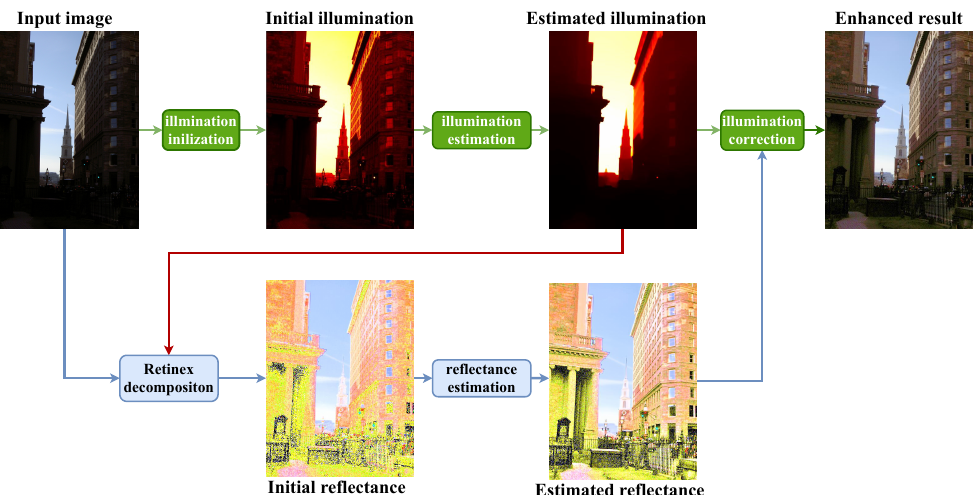
Figure 1. The framework of the proposed model. In the RGB space, the initial illumination component is first obtained to refine the estimated illumination component. Subsequently, the estimated illumi- nation component is considered as the constant in order to obtain an initial reflectance component by Retinex decomposition. Then, the denoised reflectance component is estimated. Finally, the enhanced result is composed of the corrected illumination and the estimated